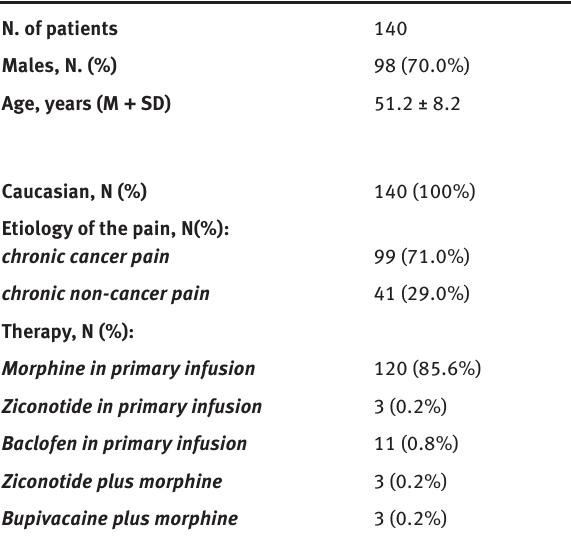
Table 1: Demographic and clinical characteristics of the 140 enrolled patients N. of